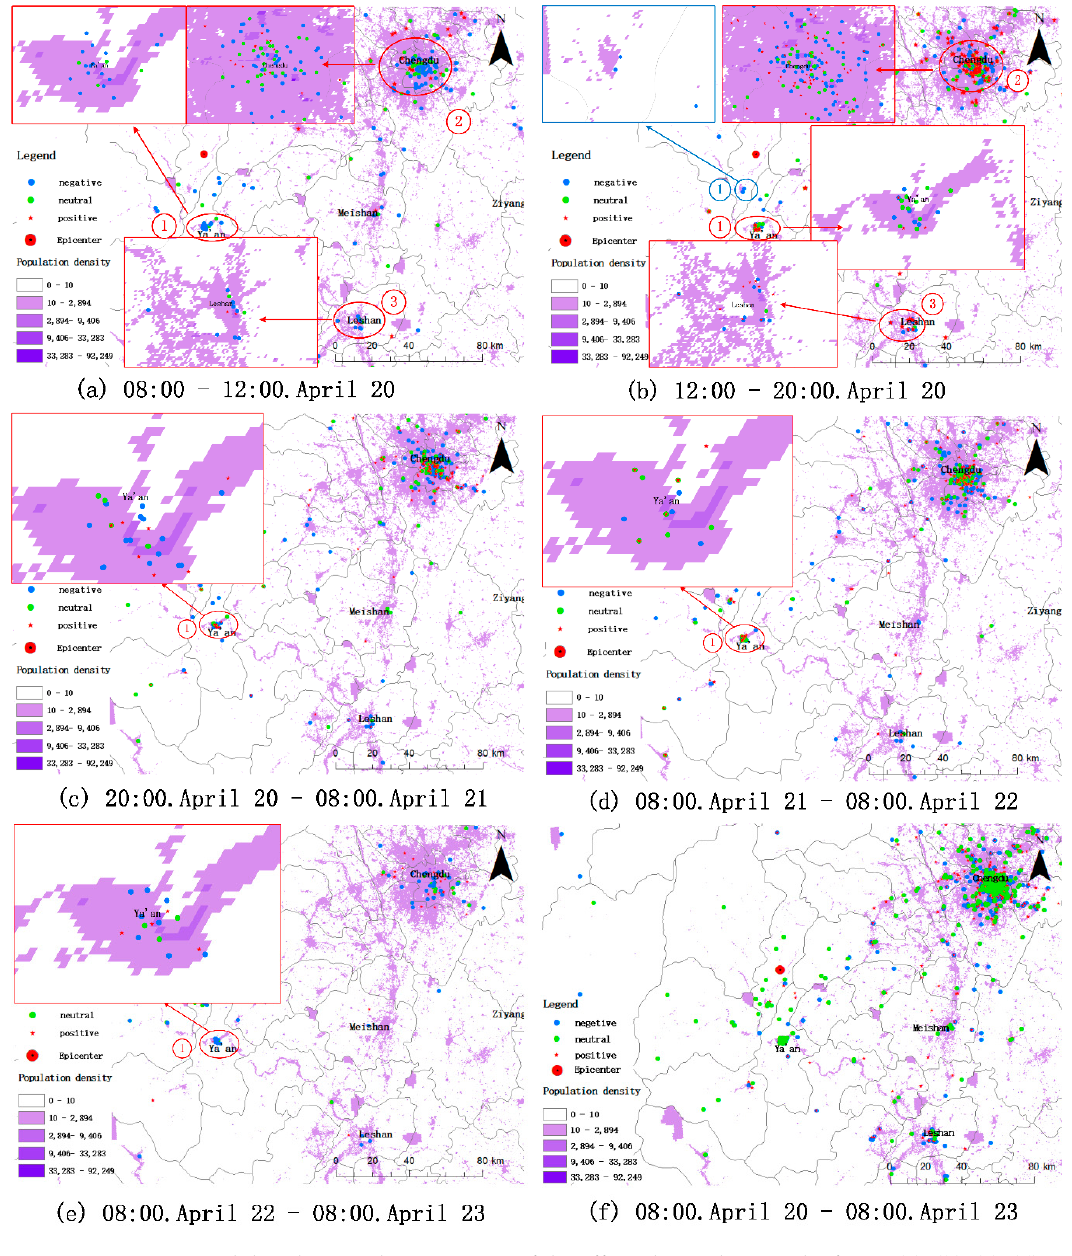
Figure 5. Emotional distribution characteristics of the affected population. The figure (a), (b), (c), (d) and (e) describe the distribution of emotions in different time periods within 72 hours after the disaster. The figure (f) shows the distribution of emotions over 72 hours. Among them, each of red circle 1, red circle 2, and red circle 3 in the figures represent the same area. The blue circle 1 in (b) shows that compared with (a), new negative emotions emerged in same